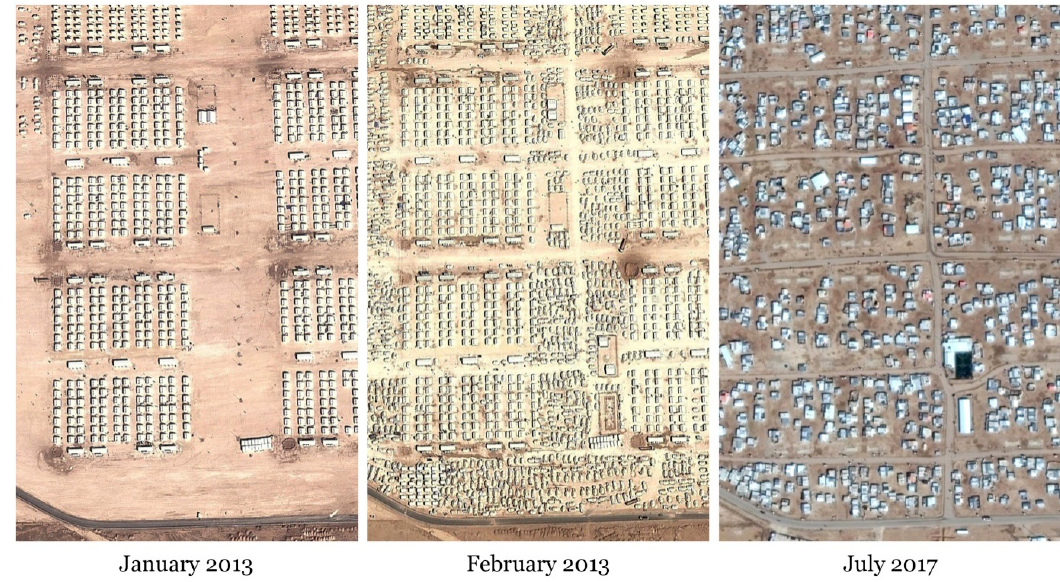
Figure 2. The subversion of Zaatari camp’s plan through daily urban practices initiated by refugees. Source: Dalal based on Google Earth in